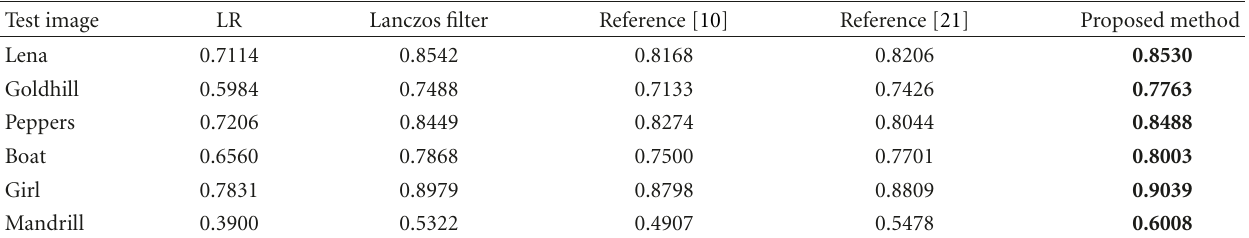
Table 1: Image enlargement performance comparison (SSIM) of the proposed method and the conventional methods (magnification factor = 4). Test image LR Lanczos filter Reference [10] Reference [21] Proposed